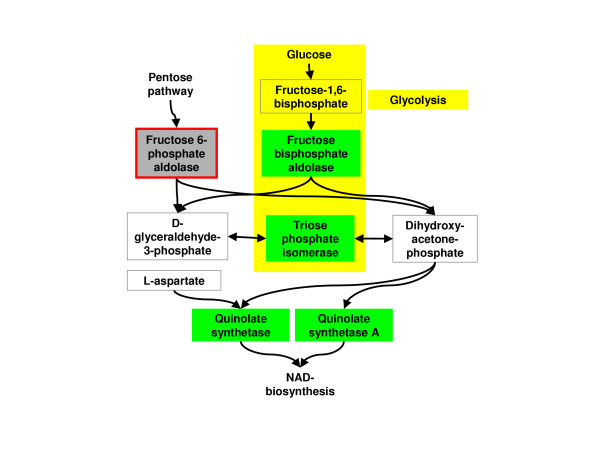
Ninth extracted sub-graph. Interface of the glycolysis (up-regulated, yellow box) and an NAD biosynthesis pathway (see text). For box colours see legend of Figure 3.